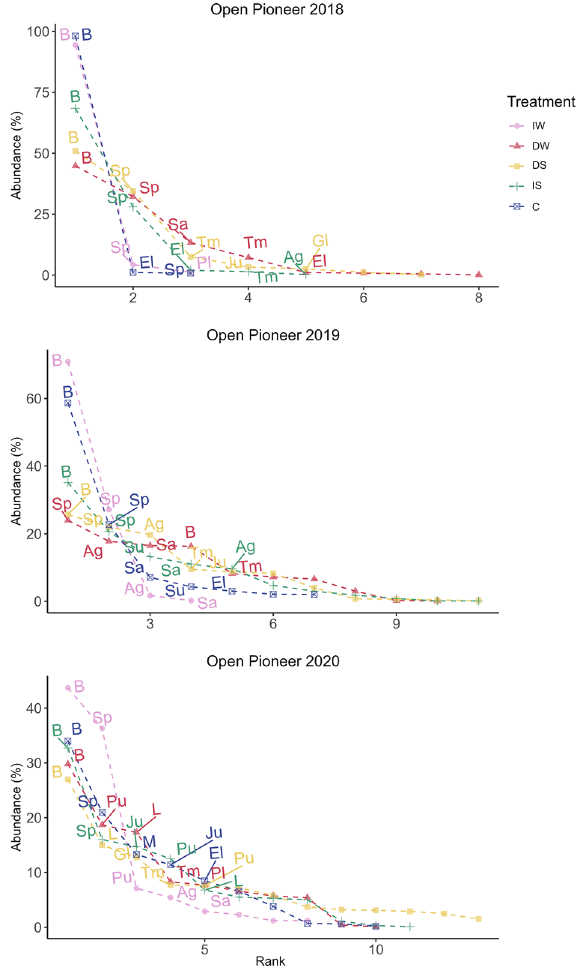
Figure 2. Rank abundance curve of the Open Pioneer community. Mean abundance as percentage cover (n = 3) for August is on the y-axis, while species are ranked consecutively on the x-axis. B Bare ground, Sp Spergularia salina , Sa Salicornia europea , Tm Triglochin maritima , El Eleocharis palustris , Ju Juncus gerardii , Pl Plantago maritima , Gl Glaux maritima , Ag Agrostis stolonifera , Su Suaeda maritima , L Litter ; Pu Puccinellia maritima . Pink: increased water level (IW); red: decreased water level (DW); yellow: decreased salinity (DS); green: increased salinity (IS); blue: control